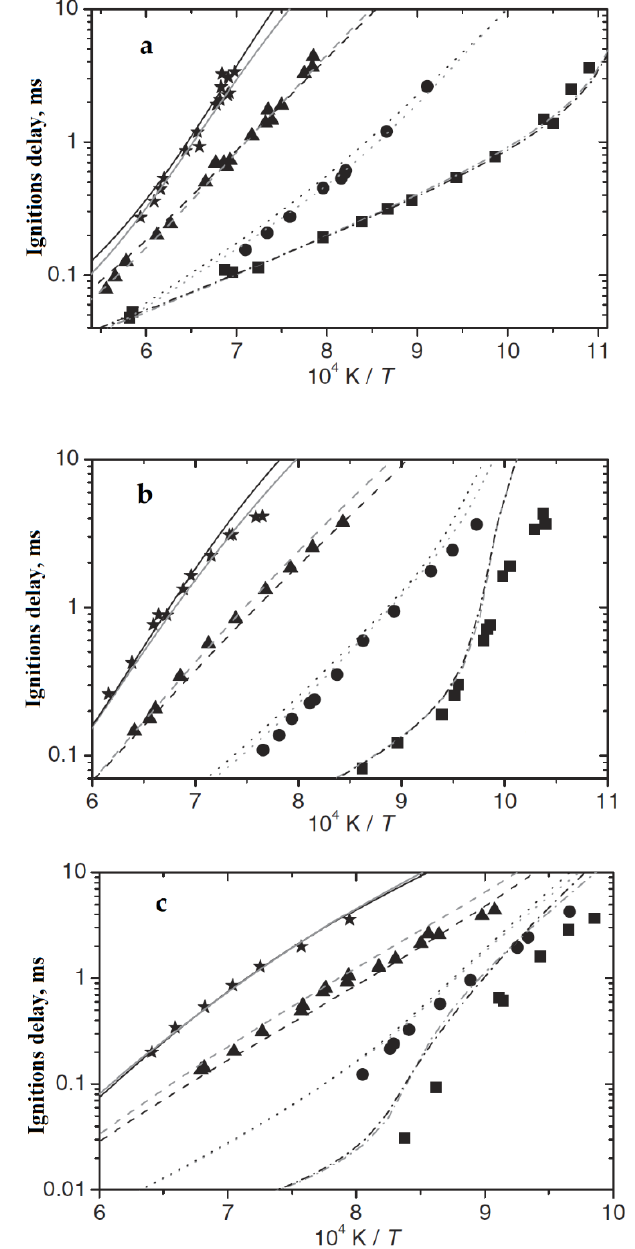
Figure 10. Measured and calculated ignition delay times for H 2 –CH 4 –O 2 –Ar mixtures ( ϕ = 1.0, 1:5 dilution) at pressures of 1 ( a ), 4 ( b ) and 16 atm ( c ). Experiments: ( ■ ) —100% Н 2 , ( • ) —80% Н 2 , ( ▲ ) —40%, ( ) –0% Н 2 . Lines represent the results of kinetic simulations (adapted from [21]).